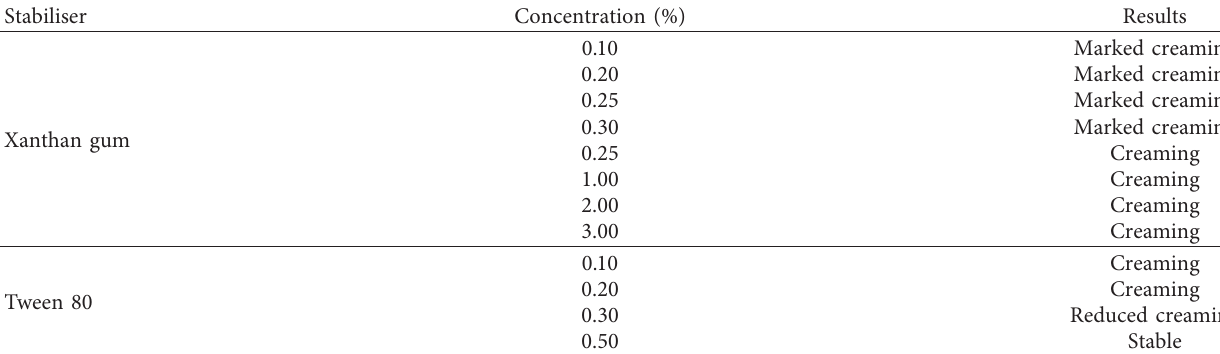
Table 4: Stabilisation of emulsions.